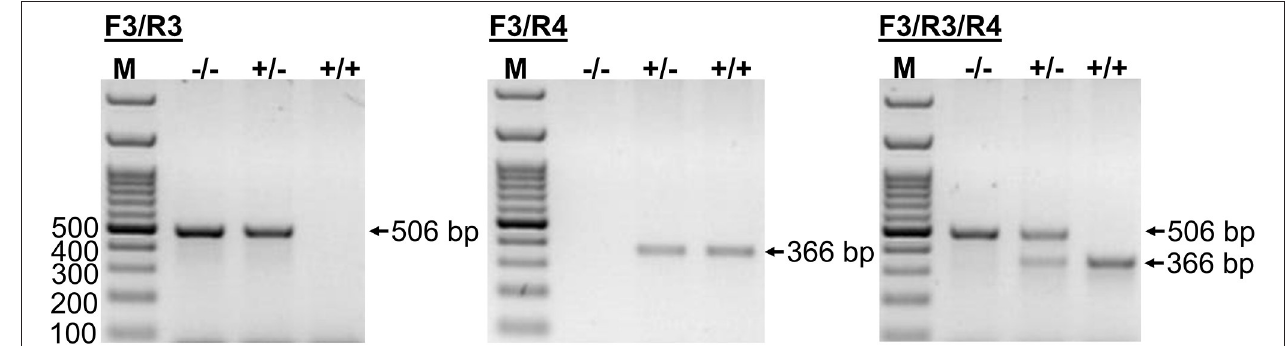
FIGURE 3 | CYP2C41 genotyping. PCR for simultaneous detection of SOR (primers SOR-F3/R3) and/or SOR1 (primers SOR1-F3/R4) allows exact CYP2C41 genotyping for all three genotypes: ( + / + ), homozygous positive; ( + /–), heterozygous; and (–/–), homozygous negative. The PCR products were separated on 2% agarose gels followed by visualization with ethidium bromide. Representative data for all three CYP2C41 genotypes are indicated. Amplification with SOR-F3/R3 (506 bp fragment) indicated the absence of the CYP2C41 gene, whereas amplification with SOR1-F3/R4 (366 bp fragment) indicated the presence of the CYP2C41 gene. Accordingly, CYP2C41(-/-) subjects only revealed the SOR-F3/R3 506 bp fragment, whereas CYP2C41( + / + ) subjects only showed the SOR-F3/R4 366 bp fragment, and heterozygous CYP2C41( + /-) dogs were positive for both fragments (366 bp + 506 bp). M, molecular weight DNA